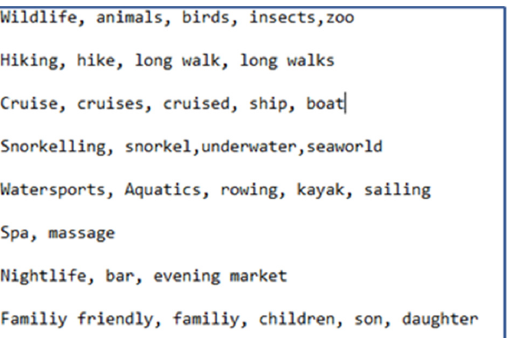
Figure 10. Data dictionary of keywords of a destination’s characteristics.